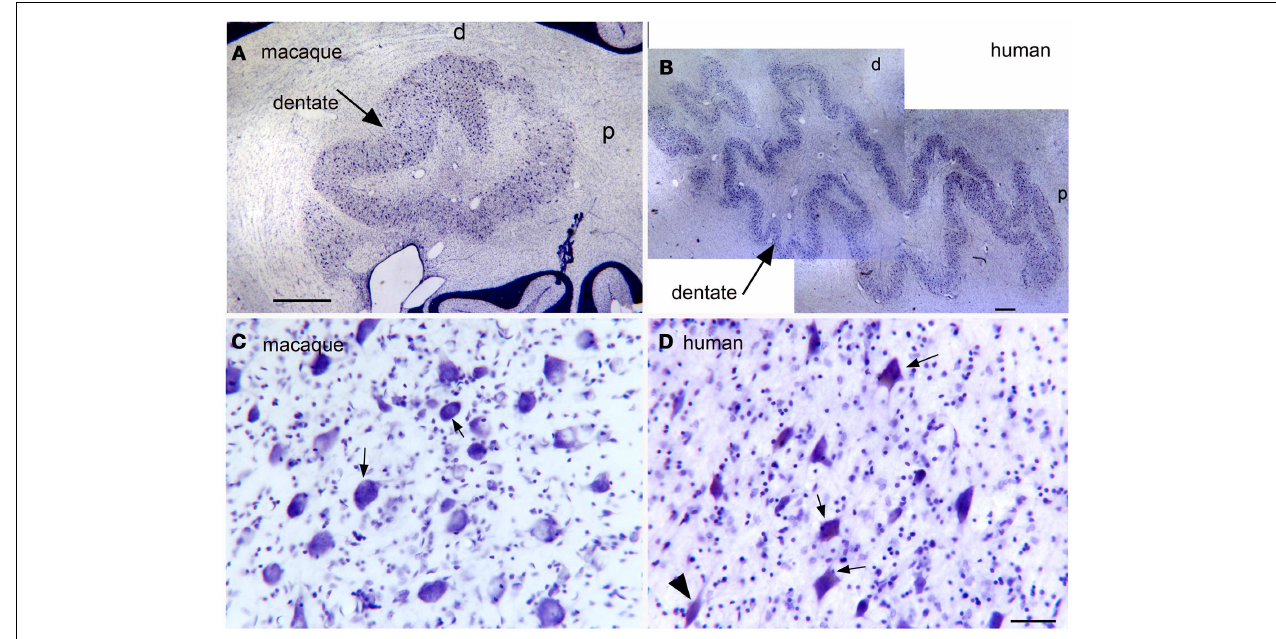
FIGURE 8 | (A) The dentate nucleus on a CV-stained parasagittal section of the macaque monkey cerebellum. Scale bar 1mm. (B) The dentate nucleus on a parasagittal CV section in the in the human cerebellum. Scale bar 1mm.